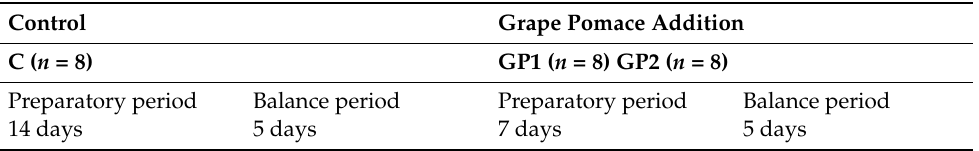
Table 1. Experiment